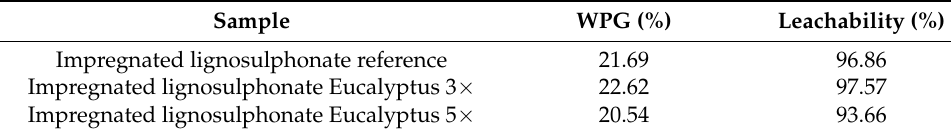
Table 8. WPG and leachability of impregnated